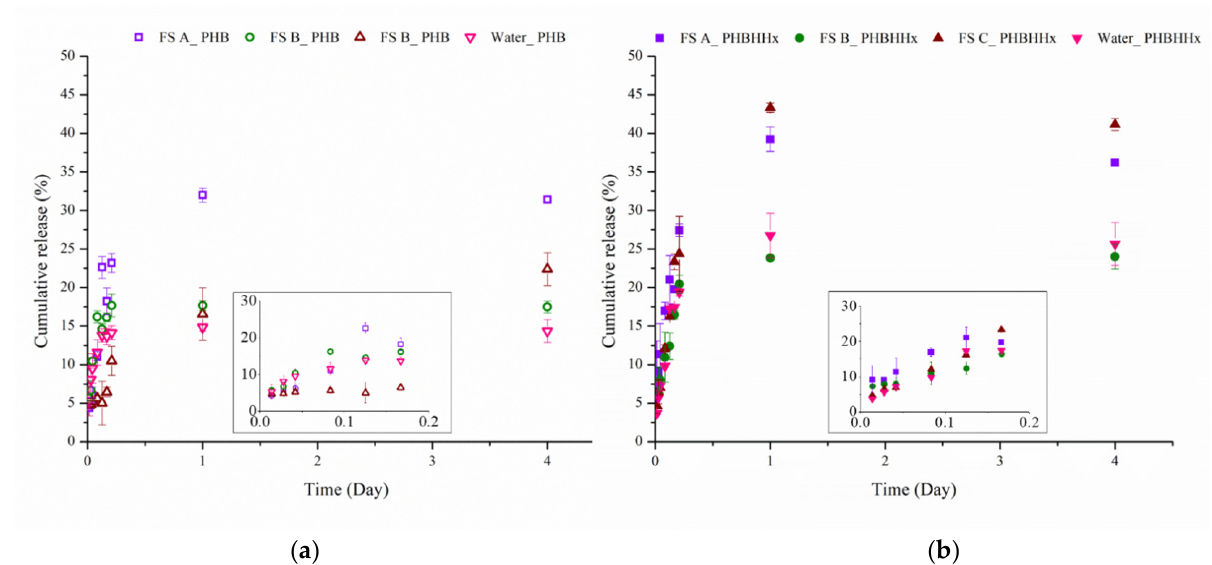
Figure 6. Cumulative release profile of EO-loaded PHB ( a ) and PHB-HHx ( b )-based NPs in different aqueous food stimulants. FS_A, square; FS_B, pointing up triangle; FS_C, circle; Water, pointing down triangle. Empty points correspond to PHB-based NPs, Full coloured points to PHB-HHX based ones. Release phase in the earliest time is highlighted in the inset plots.